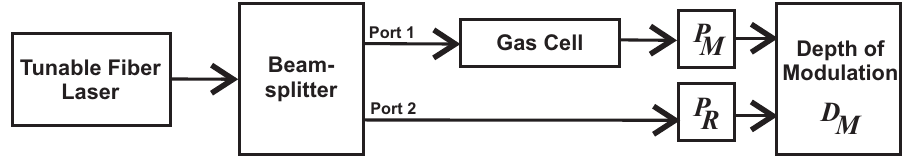
Figure 1. Block diagram of a hybrid C 2 H 2 sensor design based on the Line Locked Tunable Laser Absorption Spectroscopy (LL-TLAS) and Non-Dispersive Sensors (NDS) correlation spectroscopy